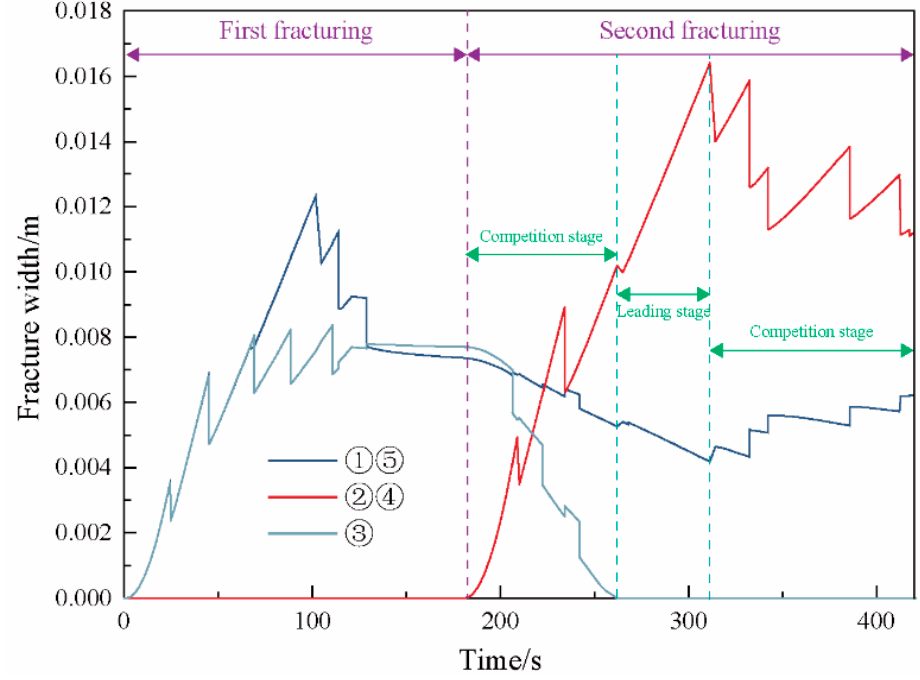
Figure 10. Fracture width. There is a competitive tendency between perforation first and subse- quent fracturing.